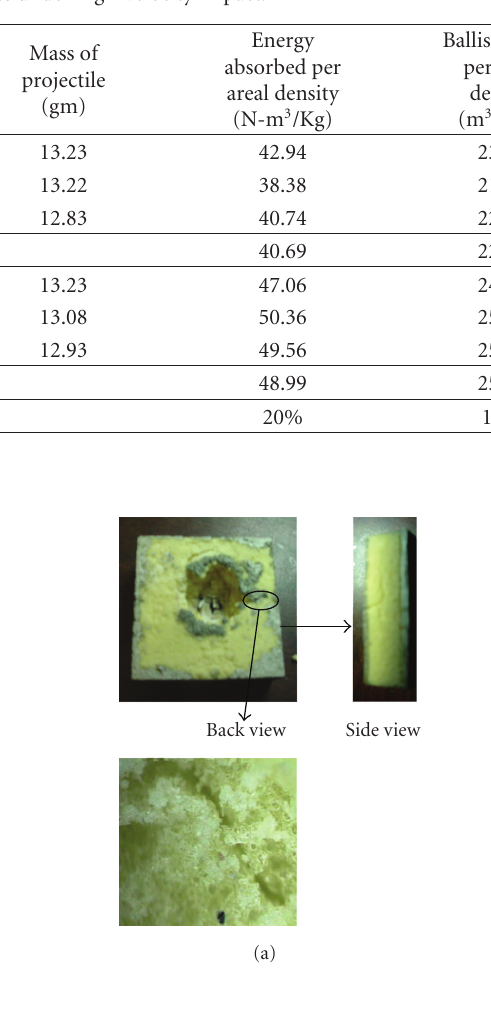
Table 2: Experimental data for sandwiches under high-velocity impact.